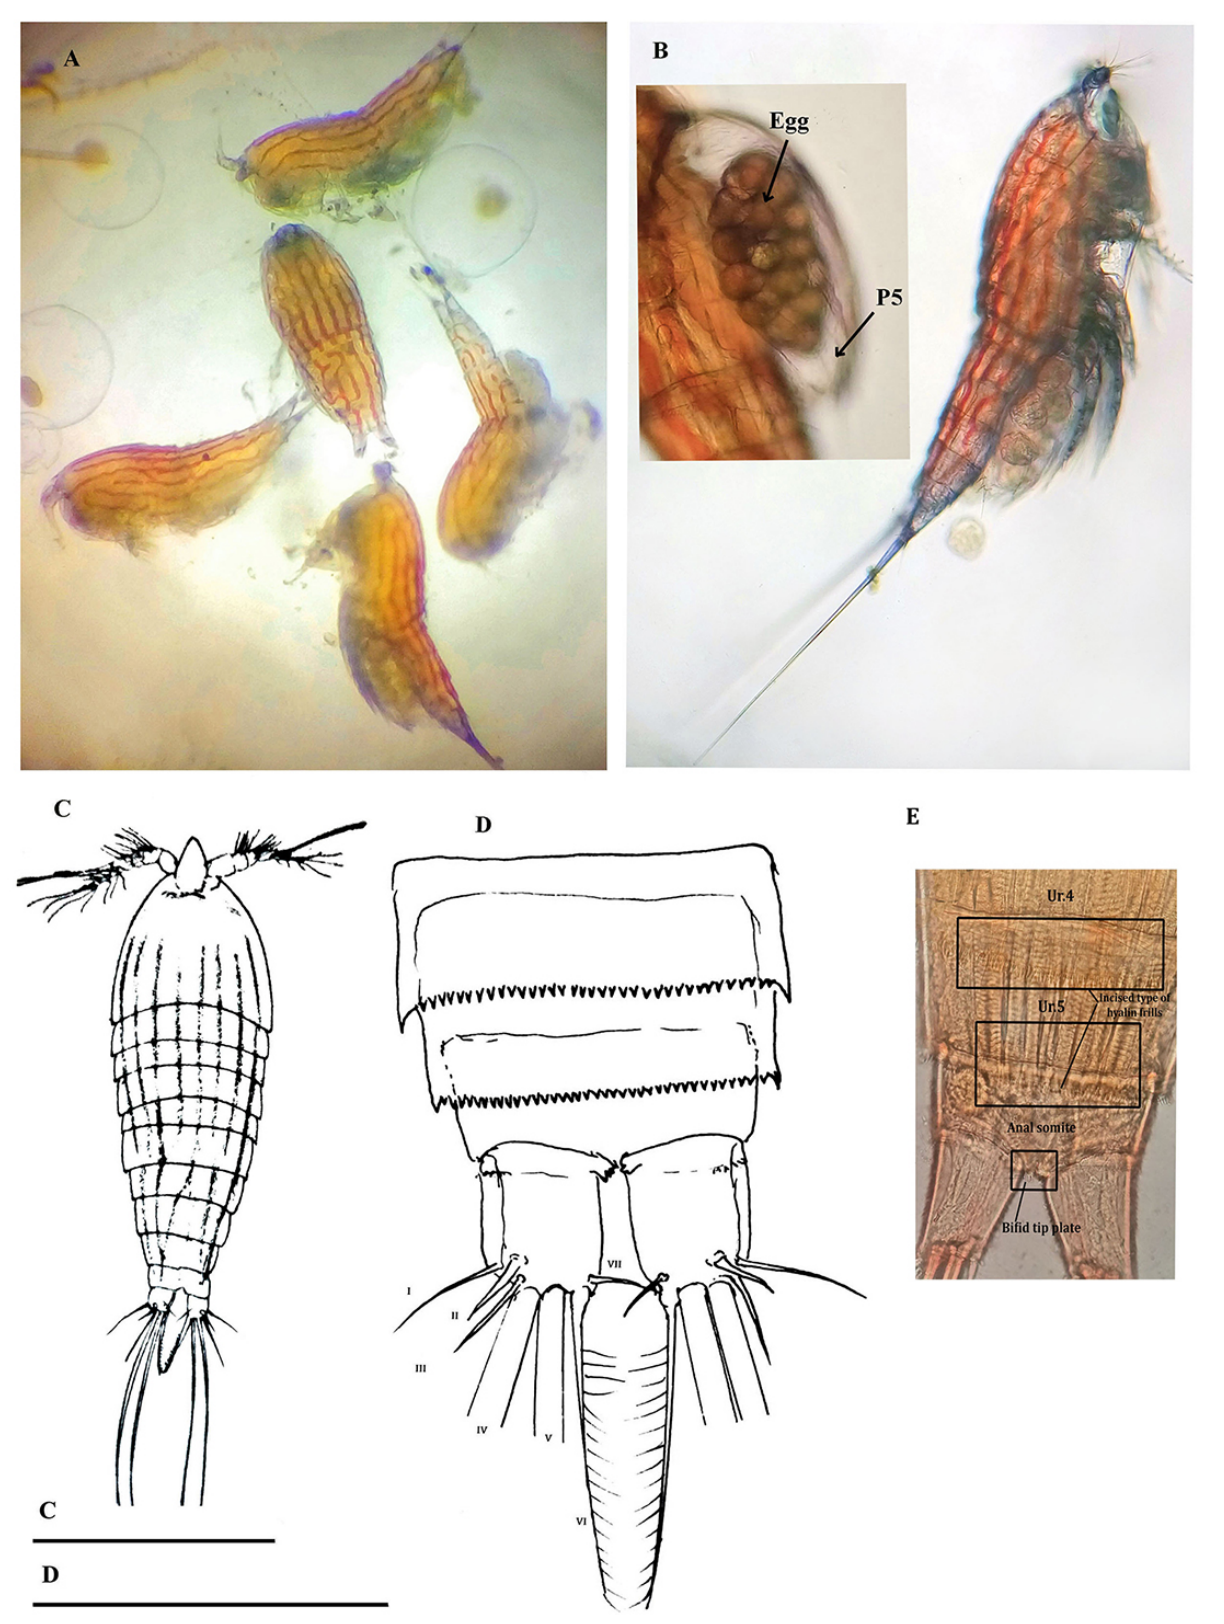
Figure 2. Eudactylopus fasciatus Sewell, 1940, female. A–C, Habitus, dorsal view; D–E, anal somite and caudal rami, dorsal. Scale bars: 100